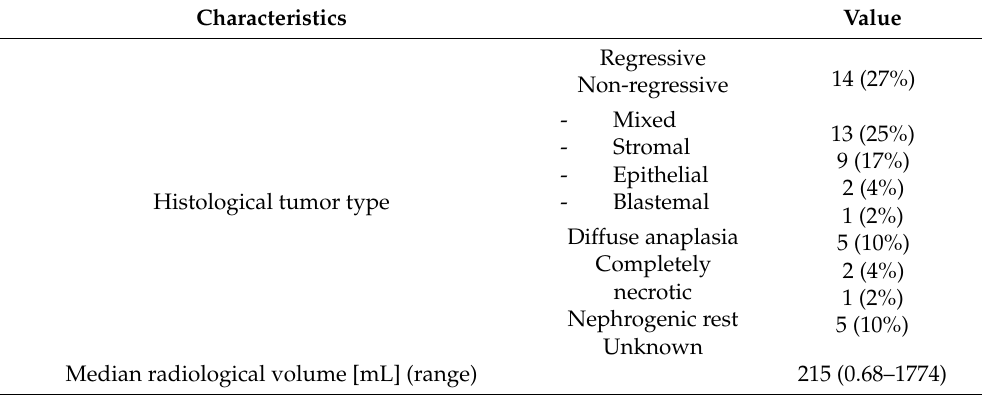
Table 3. Overview of analyzed tumors ( n = 52). Numbers are count (percentage) unless otherwise specified. For 5 tumors, histological type was unknown because these tumors were not resected.